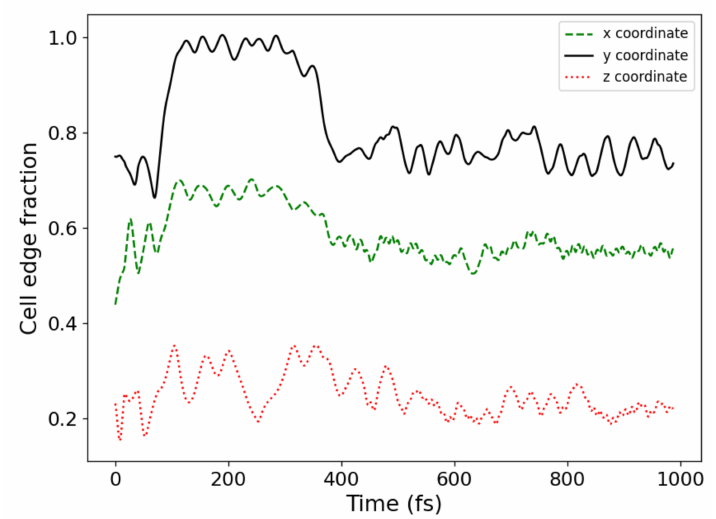
Figure 9. Time dependence of the proton Cartesian coordinates related to series 3; the initial placement of a proton corresponds to its average initial coordinates for the series.